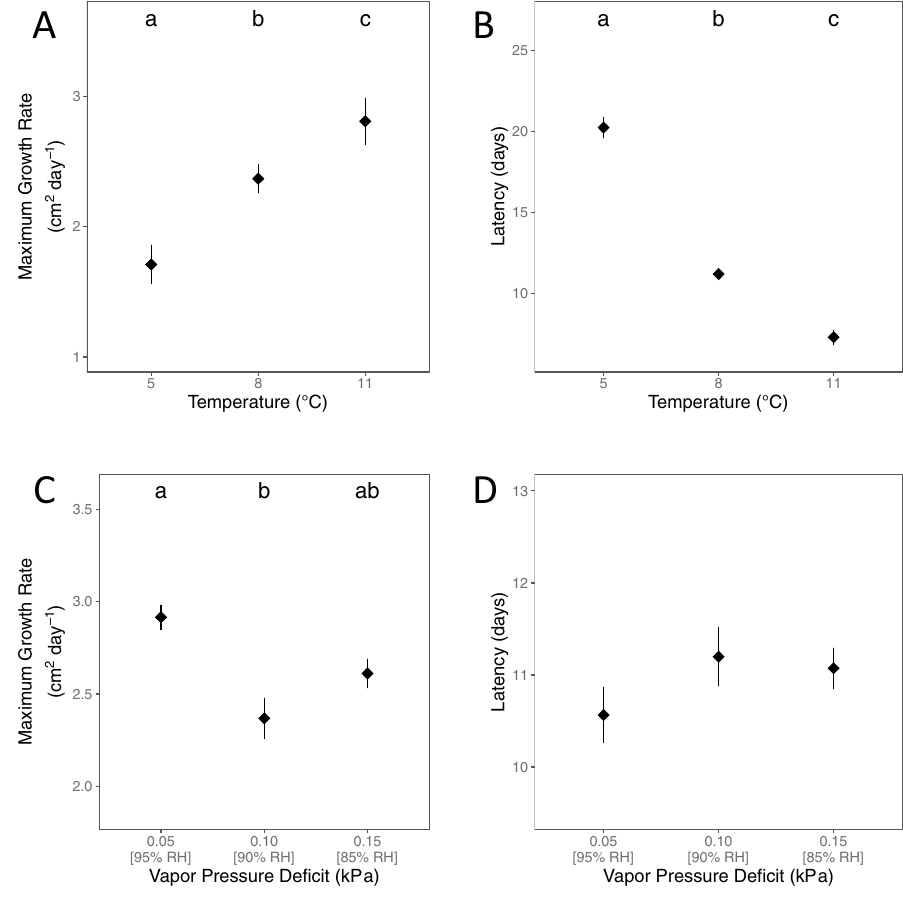
Figure 4. Influence of temperature and humidity on maximum growth rate and latency of growth of Pseudogymnoascus destructans ( Pd ) estimated based on the total area of Pd fungal growth on media plates. Actual measurements (gray circles) are shown with mean and standard error (diamond with error bars) overlaid. (A) Maximum growth rate increased with temperature, and (B) latency of growth was significantly shorter at higher temperatures. (C) Maximum growth rate was highest at the highest humidity level (vapor pressure deficit at 0.05 kPa) but did not differ significantly from the lowest humidity level (Tukey’s pairwise comparison, P > 0.05), but (D) Latency was not significantly different among humidity treatments. Different letters denote that Tukey’s post hoc pair-wise comparisons were significantly different (α =